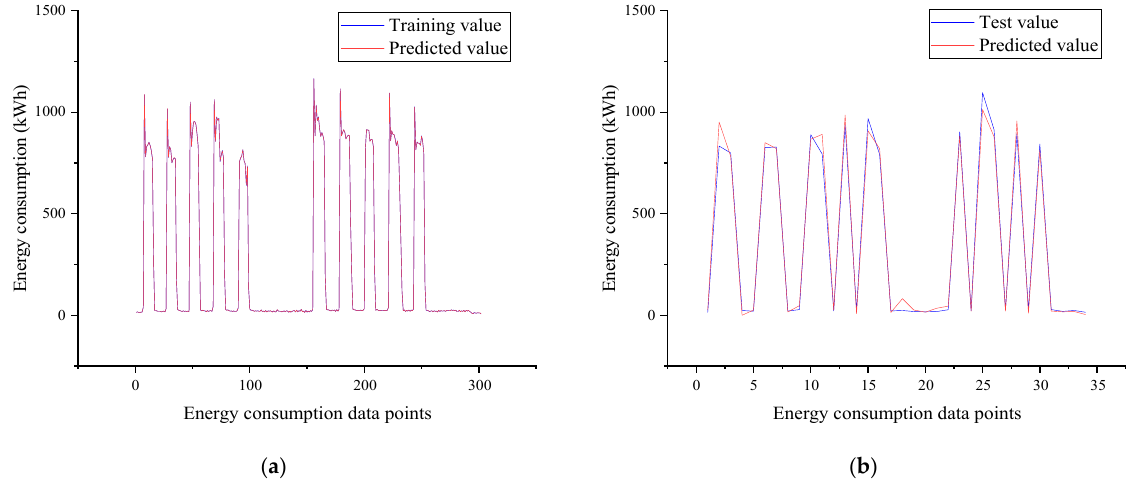
Figure 9. Optimized fitting model of the Gaussian progress regression . ( a ) Training. ( b ) Test.